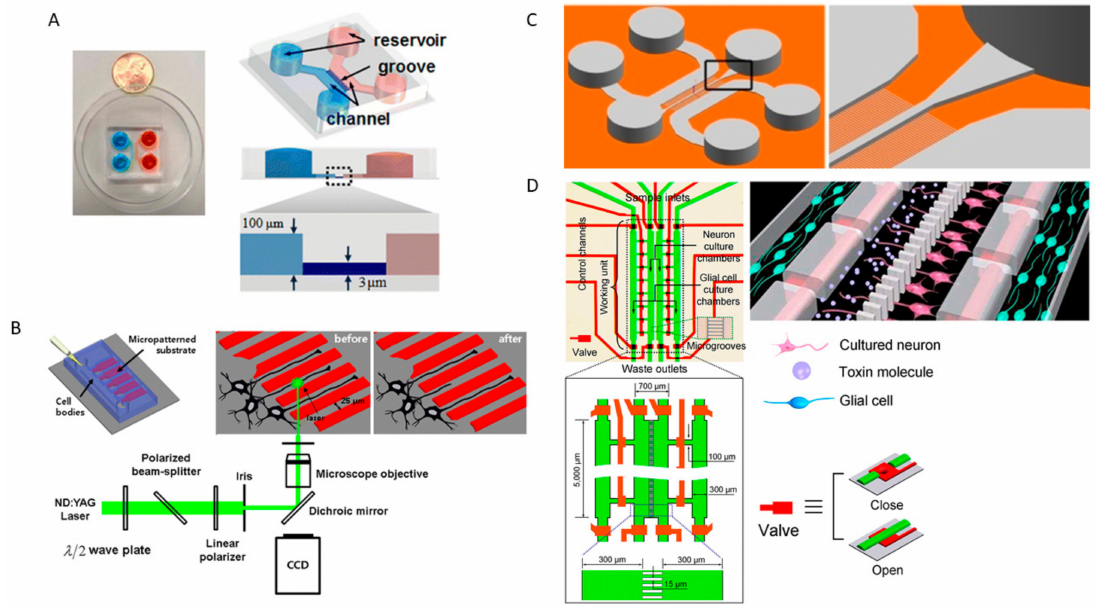
Figure 5. Schematic diagrams of axonal injury and regeneration models. ( A ) Two-chamber CMD. Figure adapted from [230]; ( B ) Pulsed laser microbeam integrated microfluidic device. Figure adapted from [230]; ( C ) Three-chamber CMD [232]; ( D ) Multi-chamber CMD controlled with valves. Figure adapted from